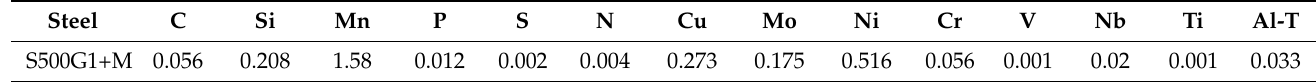
Table 1. Chemical composition of the S500G1+M steel (w%) [34].